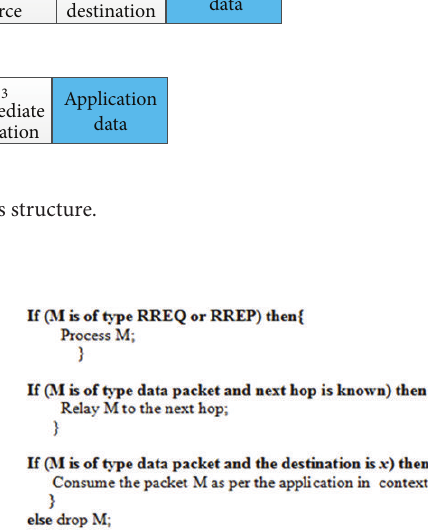
Figure 11: Processing steps of received packet M in